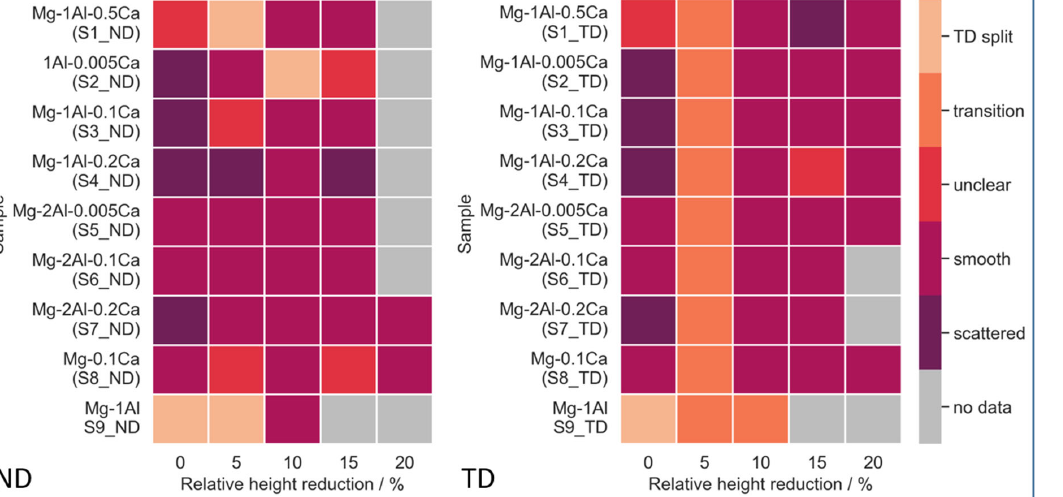
Figure 3. Overview of the pole-figure types for the investigated alloys. Left, S_ND samples, and Right, S_TD samples.